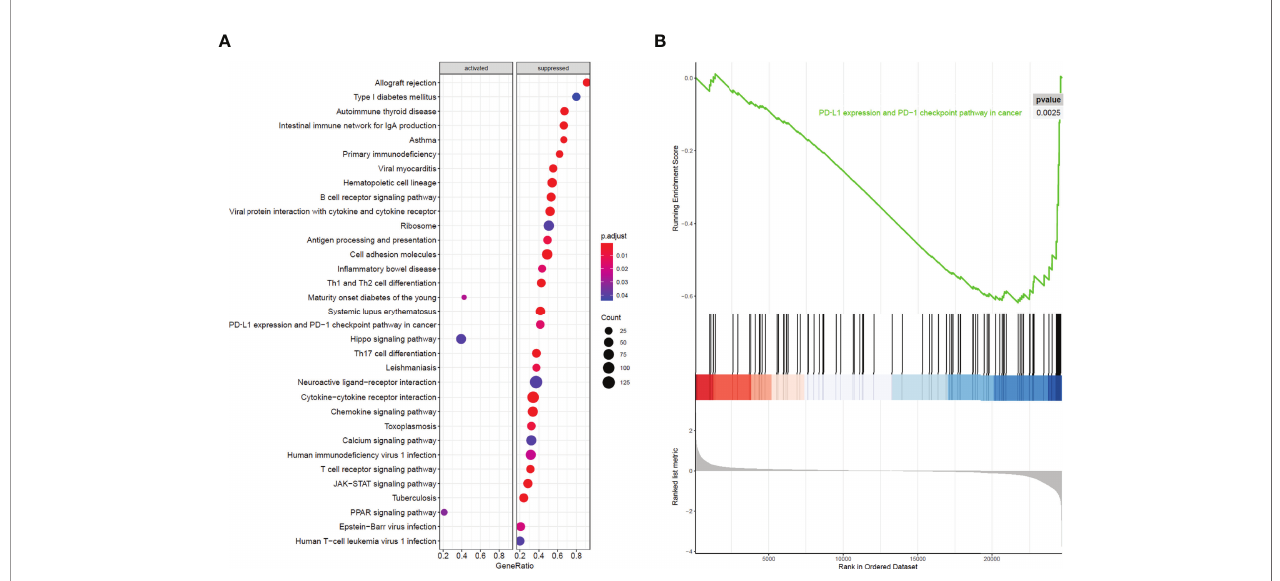
FIGURE 9 | GSEA analysis and PD-L1 pathway. (A) GSEA analysis demonstrated 33 KEGG pathways associated with risk score in cervical cancer. (B) PD-L1 expression and PD-1 checkpoint pathway in cancer was one of the 33 pathways that signi fi cantly related with risk score.